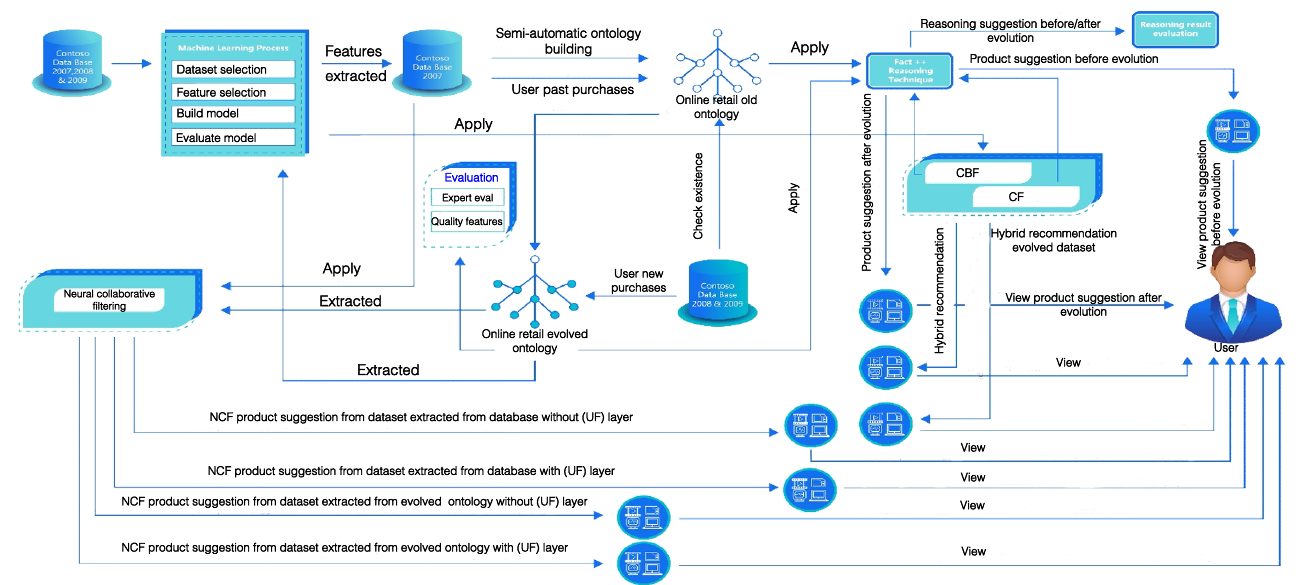
Figure 1. System architecture: Phase ϕ 1 is a pre-classification used for feature extraction ( top left , machine learning process); Phase ϕ 2 uses the classification results and the features to build the base retail ontology ( middle and top right blocks); Phase ϕ 3 derives the evolved ontology after adding the new information ( center part); Phase ϕ 4 uses NCF ( middle left block) jointly with CF and CBF ( top right ) to build the ensembled